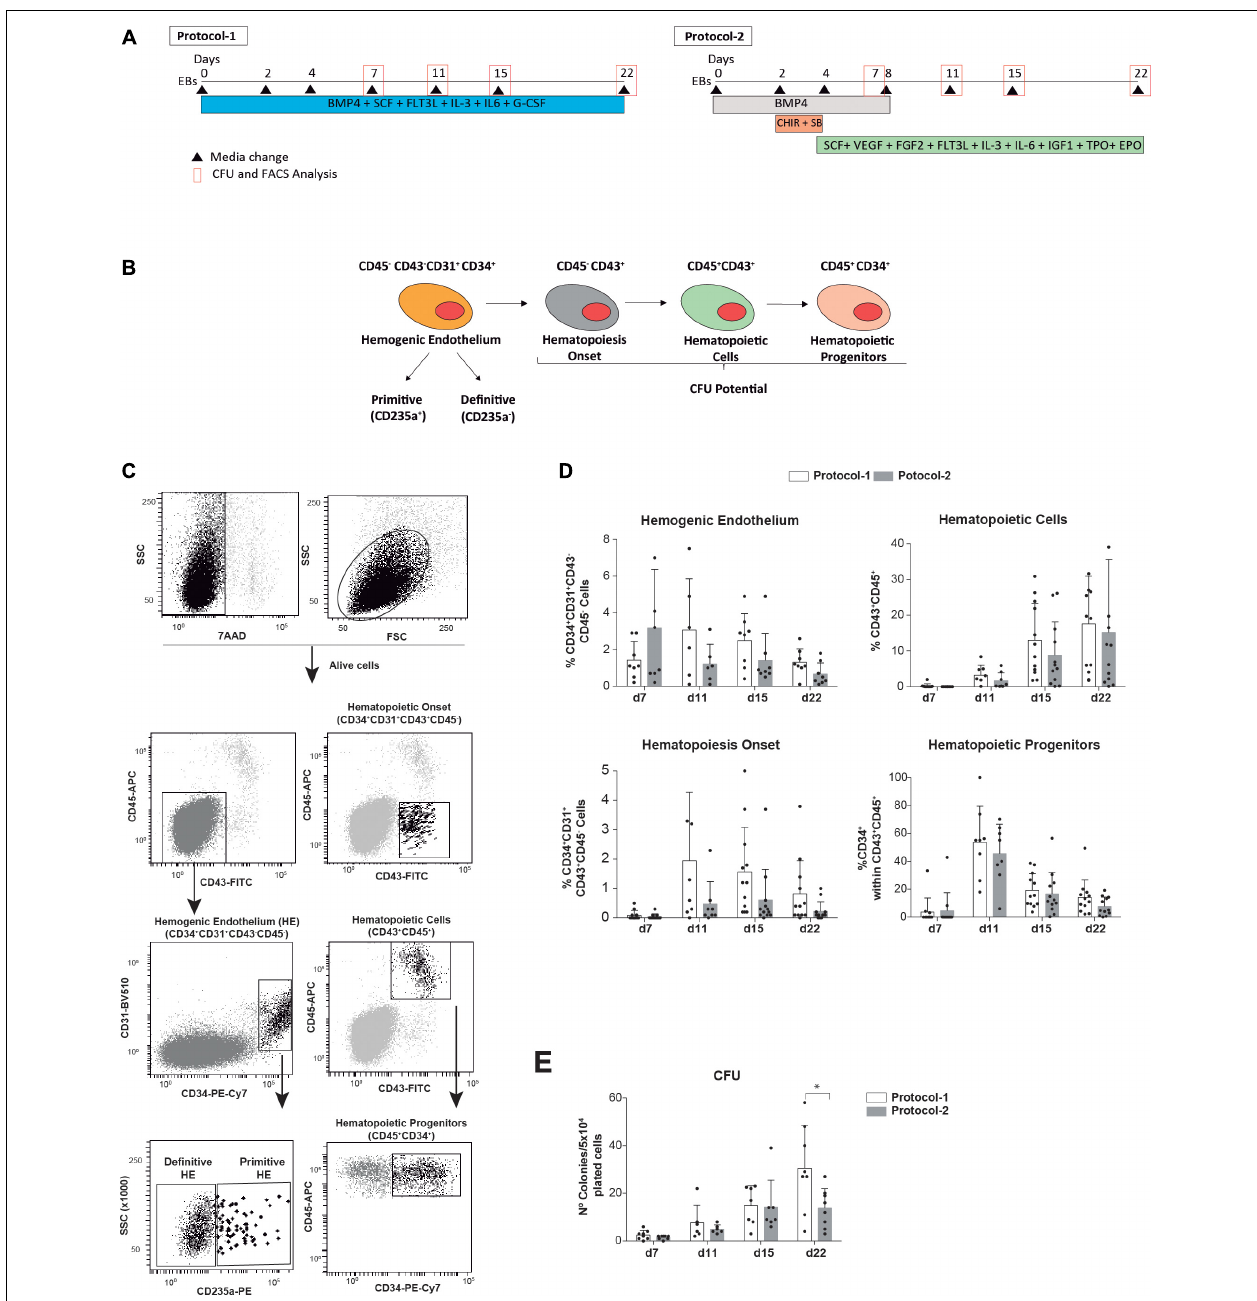
FIGURE 1 | Side-by-side comparison of two well-established EB-based directed hematopoietic differentiation protocols. (A) Schematic of the differentiation protocols (protocol 1 and protocol 2) and time-point analyses. (B) Cartoon depicting the hematopoietic cell fate specification through the formation of hEBs. (C) Representative FACS analysis and identification of the indicated alive hematopoietic cell populations analyzed during hematopoietic commitment of hPSCs. (D) Frequency of alive (7AAD–) HE precursors (CD45–CD43–CD34 + CD31 +), CD43 + CD45– and CD45 + hematopoietic cells, and hematopoietic progenitors (CD45 + CD34 +) analyzed at the indicated time points throughout EB development ( n = 8). (E) Clonogenic progenitors detected by hematopoietic CFU assays were analyzed at the indicated time points ( n = 8). Each individual dot represents the value for each independent in vitro differentiation experiment. Data were plotted as mean ± SD. n.s., not significant. * p value < 0.05.